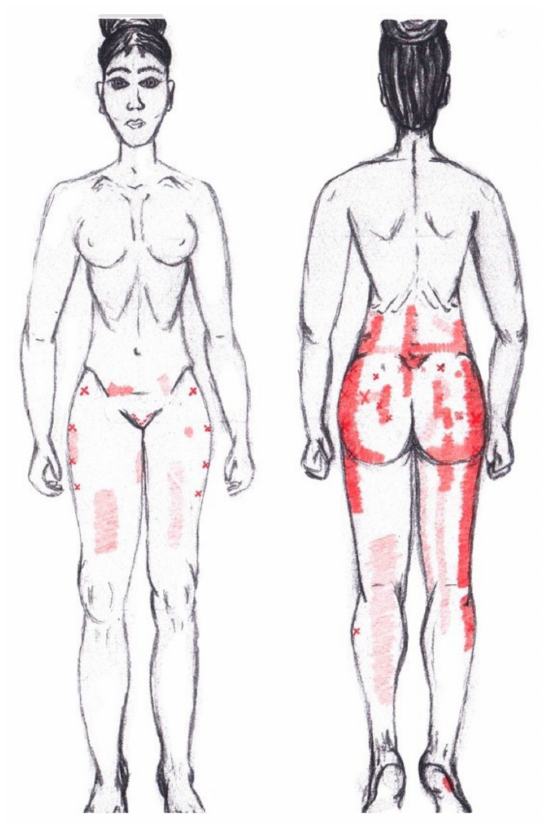
Figure 10. Graphical simulation of referred pain areas of the gluteus minimus muscle. The frequency at the areas of referred gluteus minimus muscle pain in the menstrual phase and in the ovulatory phase is shown in Tables 9 and 10,